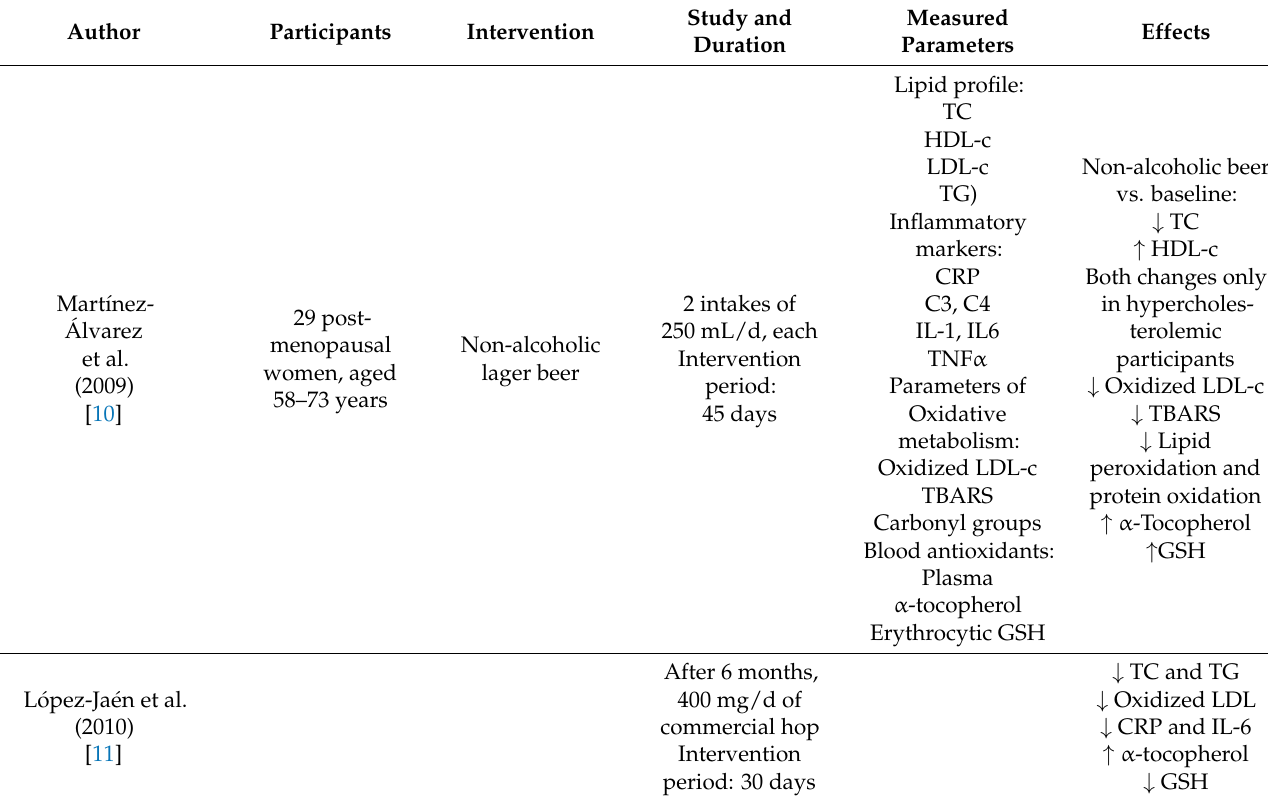
Table 1. Studies carried out with non-alcoholic